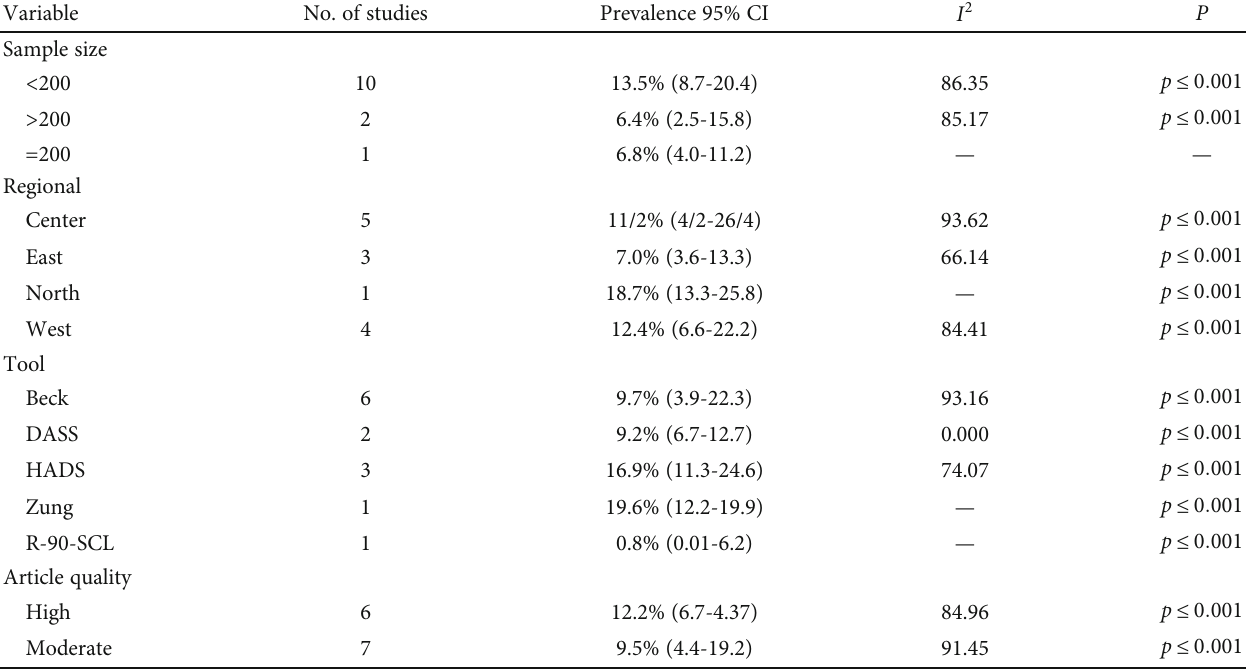
Figure 2: Forest plot of the included studies based on the random-e ff ects model. Table 4: Subgroup analyses of the included